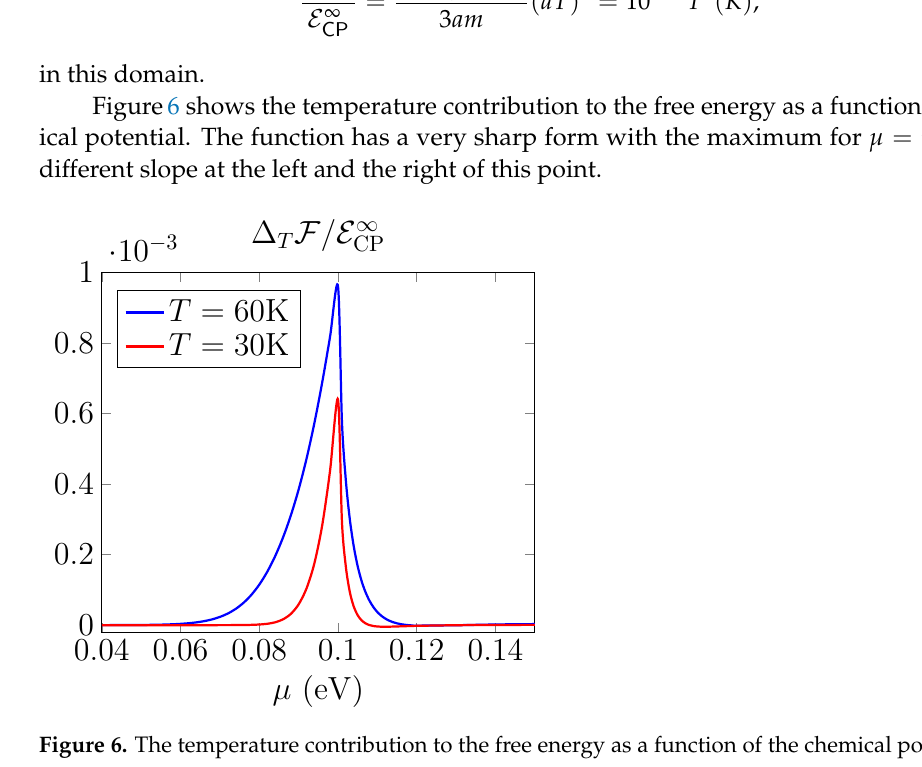
Figure 5. The temperature contribution to the free energy in the different intervals of temperatures and µ For zero chemical potential (brown curve), the temperature correction is, in fact, zero for the large domain of temperatures. The closer µ to m , the smaller domain in which temperature correction is zero. According to (30b), ∆ 128 η gr ζ R ( 5 ) T F = ∞ CP E in this domain.